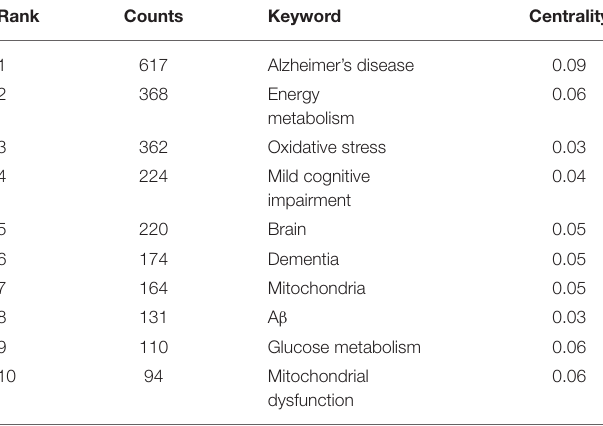
TABLE 8 | Top 10 co-occurrence times of